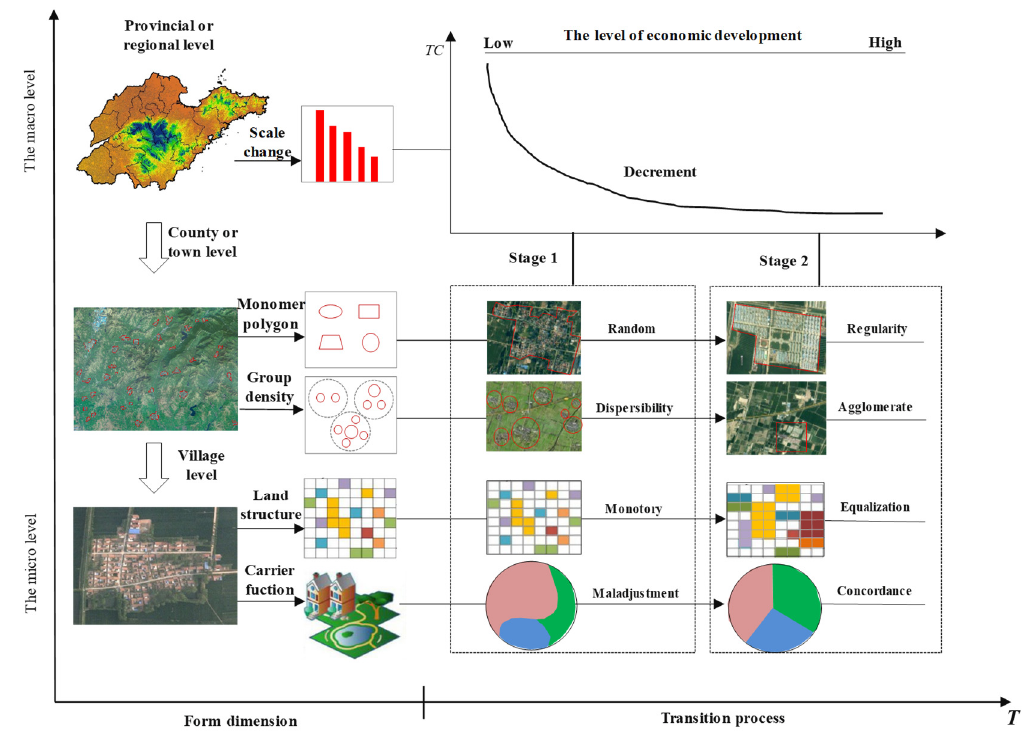
Figure 1. Theoretical framework of rural residential transition based on dimension reduction.